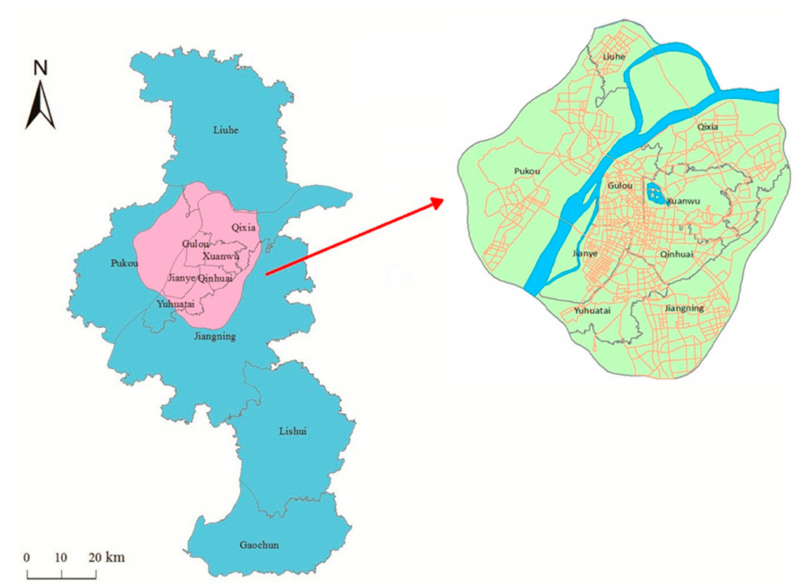
Figure 1. The study area with road network in